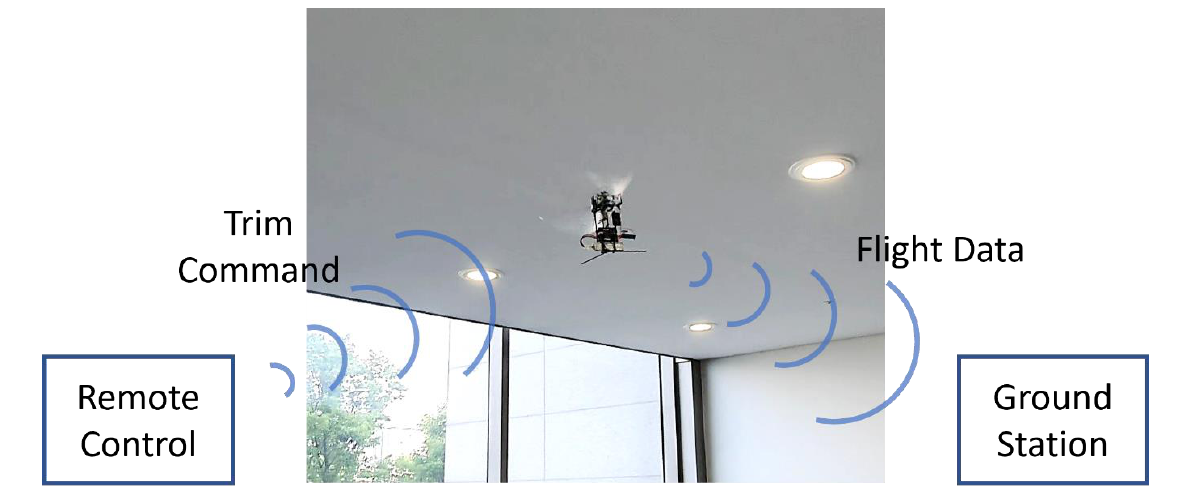
Figure 3. Experimental flight setup for data acquisition.